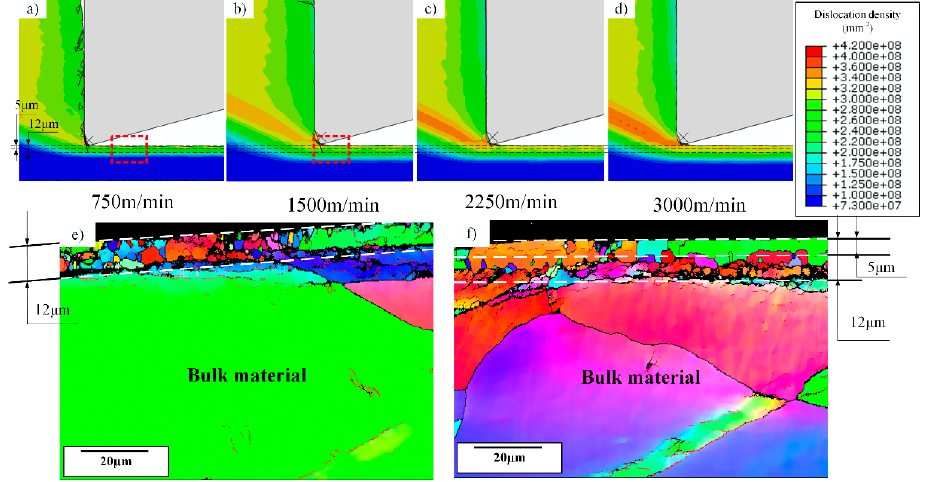
Figure 13. Distribution of statistically stored dislocation densities in sub-surface with the increase of cutting speeds, ( a )–( d ) are the simulation results from 750 m/min to 3000 m/min, ( e ) and ( f ) are the experimental data inside the red rectangular in ( a ) and ( b ), respectively.